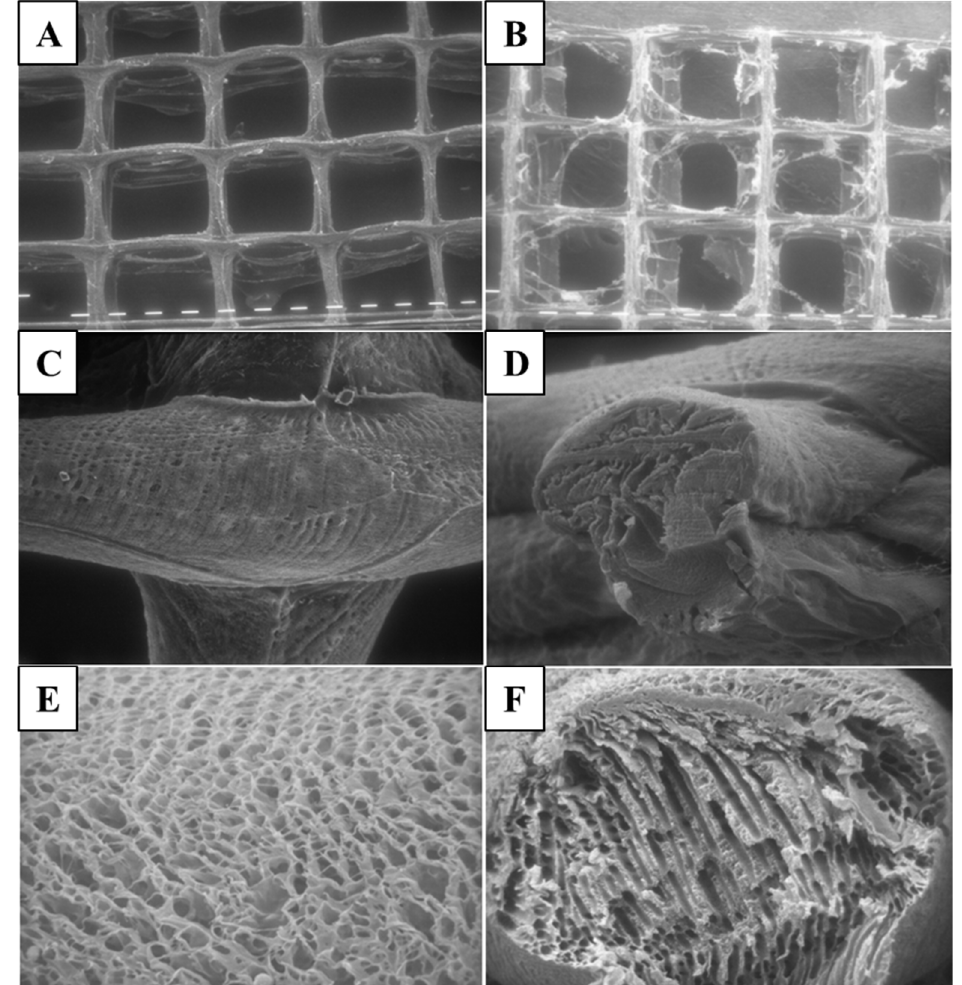
Figure 2. SEM pictures of 3D hydrogels. Calcium alginate hydrogel ( A ) without SSD and ( B ) containing SSD (magnification 40X); calcium alginate hydrogel surface ( C ) and cross-section ( D ) (magnification 320X); ( E ) chitosan hydrogel gelled in ammonia vapor surface (magnification 1250X) and ( F ) cross section (magnification 640X).